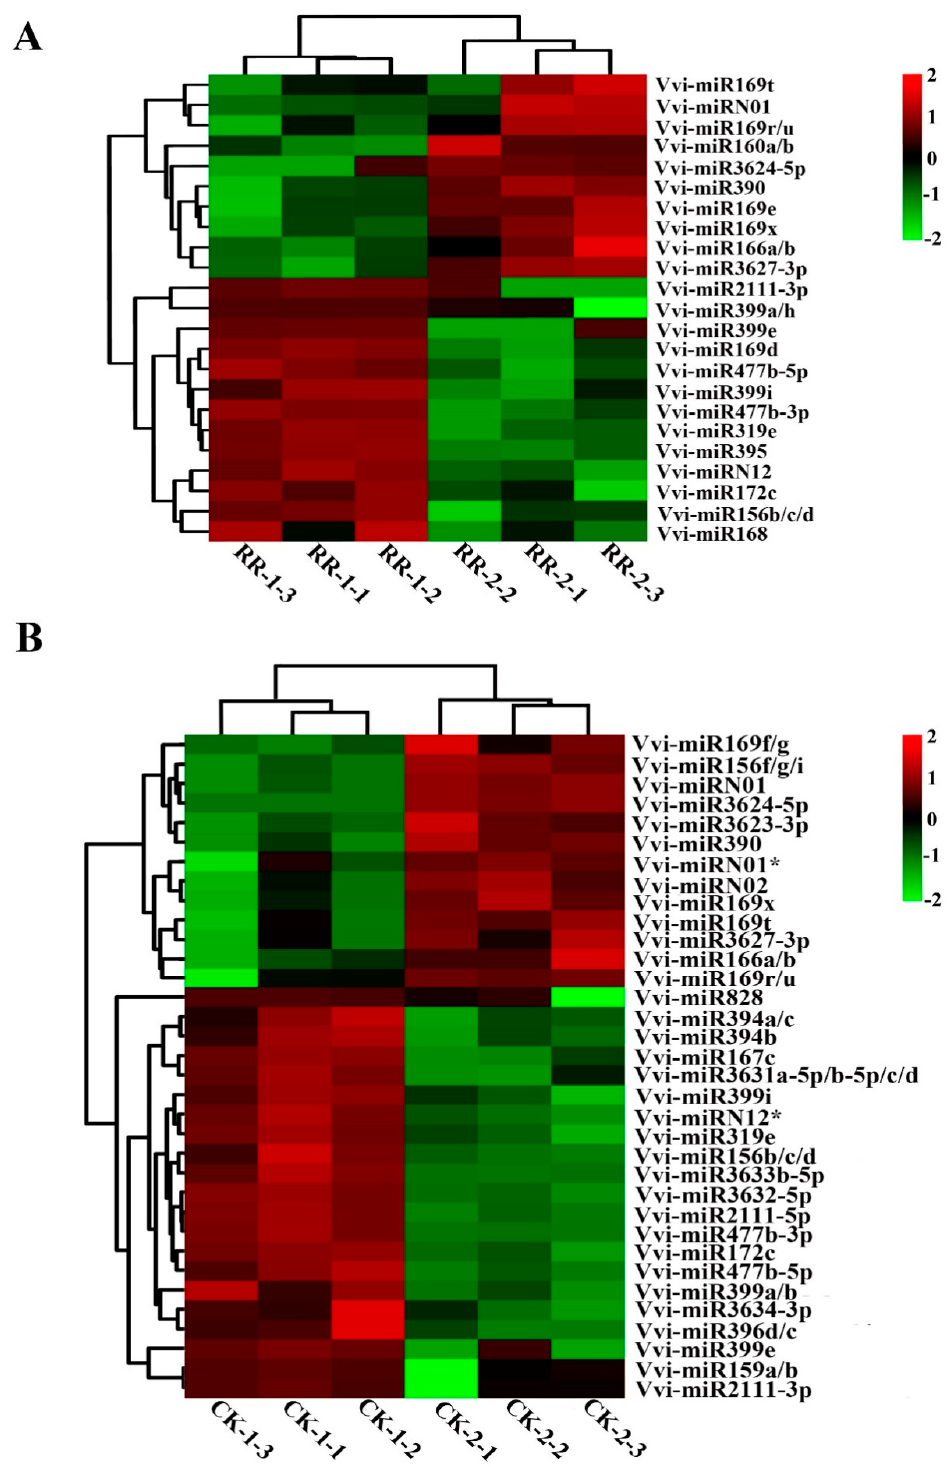
Figure 5. Heat maps of the normalized expression level (TPM) of differentially expressed miRNAs at different periods of the same treatment. ( A ) and ( B ) were from samples collected from trees grown under root restriction and non-root restriction, respectively. RR-1: fruits collected on 14 July 2017 grown under root restriction; CK-1: fruits collected on 14 July 2017 grown under non-root restriction; RR-2: fruits collected on 9 August 2017 grown under root restriction; CK-2: fruits collected on 9 August 2017 grown under non-root restriction.